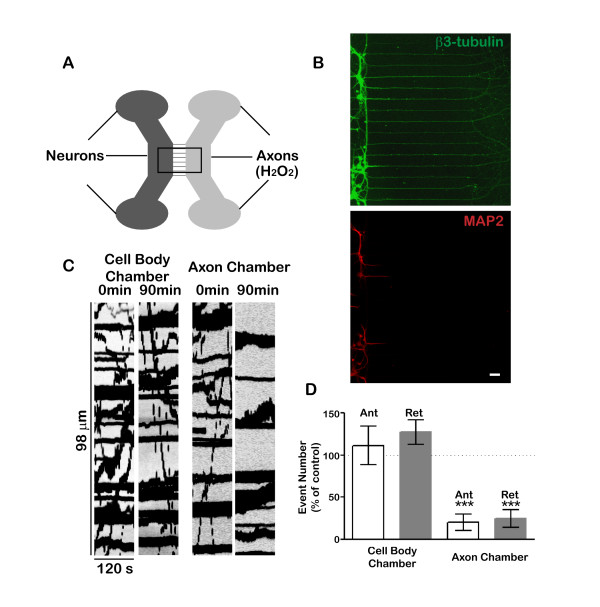
Local hydrogen peroxide exposure inhibits axonal transport. Neurons were cultured in Xona® microfluidic chambers, which permit independent control of the fluid environment surrounding the axonal and somato-dendritic compartments. (A). Neurons were seeded in the cell body chamber. After 5–10 days, their axons extended through the microchannels and into the axon chamber. The length of microchannels (450 μm) ensures that only axons extend far enough to enter the other side. Beta3-tubulin staining (green) and MAP2 staining (red) confirmed that cell bodies and dendrites were confined in the cell body chamber and only axons extended into the axon chamber (B). Mitochondrial transport was imaged in both the cell body and axon chambers before treatment. Then hydrogen peroxide (100 μM) was added into the axon chamber. Mitochondrial transport in axon chamber was severely inhibited 90 m after hydrogen peroxide treatment while transport in cell body chamber was largely intact (C). D. Quantification showed that transport in the axonal compartment was inhibited by more than 80% (*** P < 0.001 paired student t-test). Error bar indicates standard error.